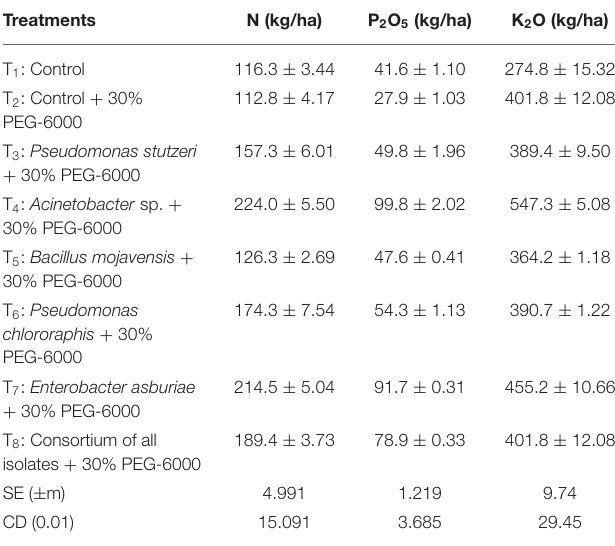
TABLE 2 | Details of the nutrient status of